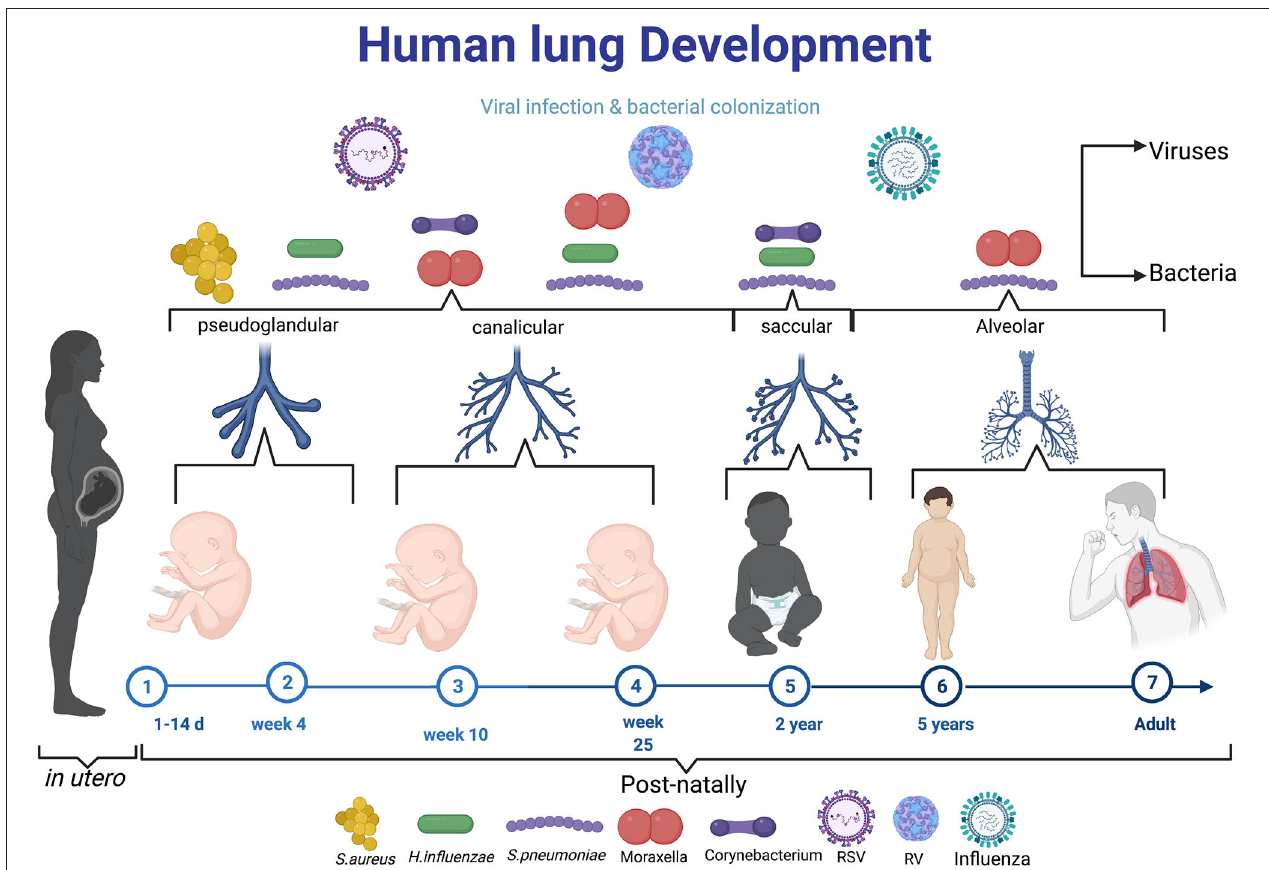
FIGURE 1 | The diagram elaborating the neonatal exposure to viral and bacterial infections during the crucial stage of lung development. During pseudoglandular and canalicular of lung development (Day 1–25 week) where lung are thought to be more susceptible to early-life pathogens like Respiratory syncytial virus, S. aureus . From 25 week to 2 years (saccular), the most reported microbes in this age are RV, H. influenza , S. pneumonae , Moraxella, Corynebaterium, and then influenza virus can infect at time from birth to school age and adult. Created with